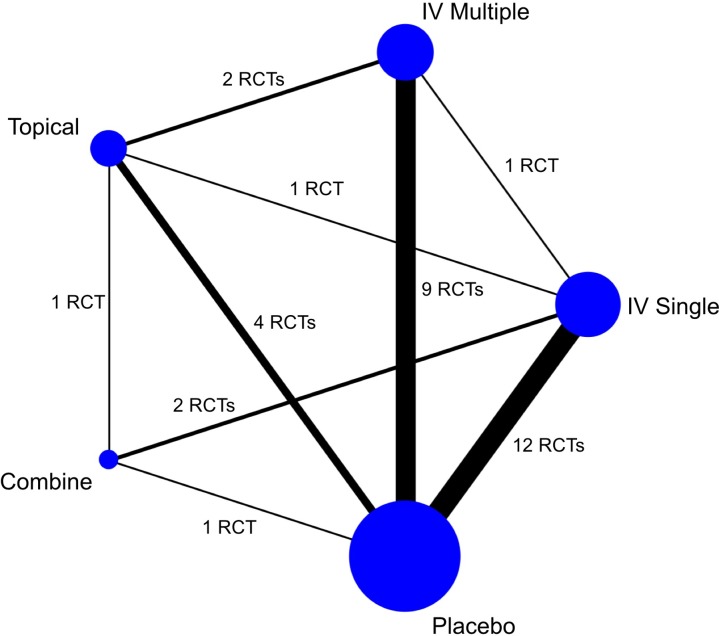
Network plot depicting the direct evidence used in the network meta-analysis, which included 25 randomized controlled trials, and 33 direct comparisons due to four multi-arm trials.The circle size is proportional to the number of patients, and line thickness is weighted proportionally to the number of trials that assess the comparison.